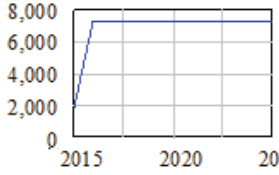
Fig. 15. Heat energy production by CHPs and boiler-houses.